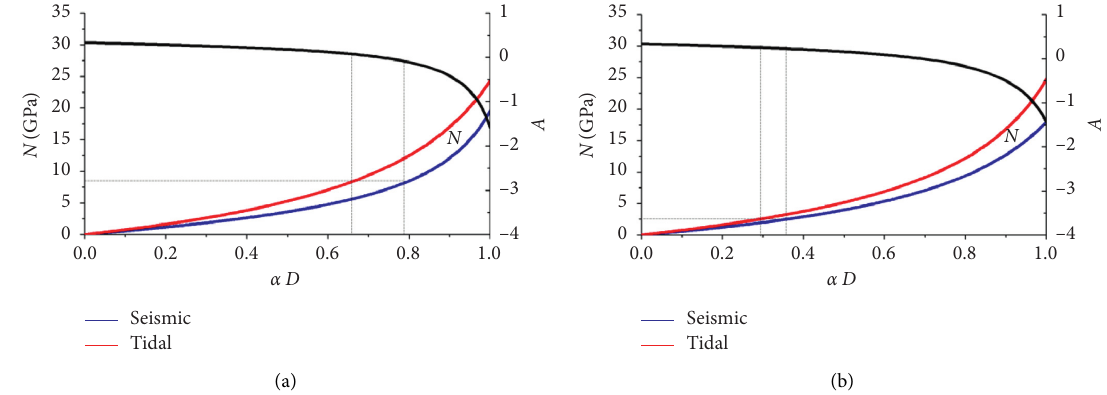
Figure 4: The deviatoric strain coupling: A and N , as a function of rock damage ( α earthquake. (b) Kaik � oura